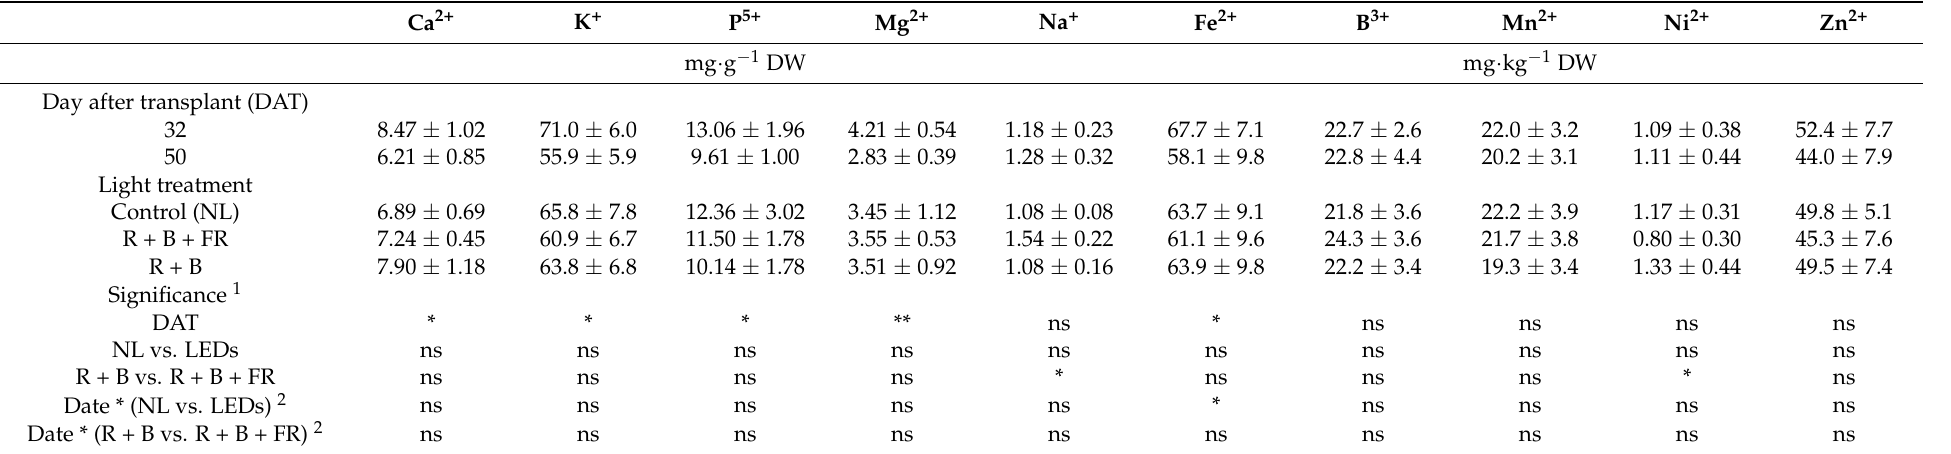
Table 5. Effects of the day of harvest and light treatments on the mineral content of the fruits of a landrace of Cucumis melo L. (“Carosello leccese”). Values are average ± SD of three